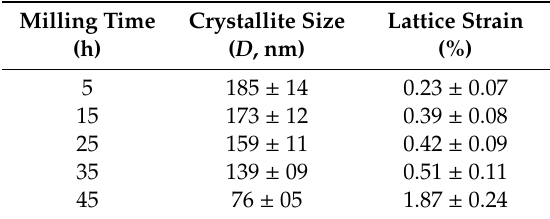
Table 2. Crystallite size and lattice strain.